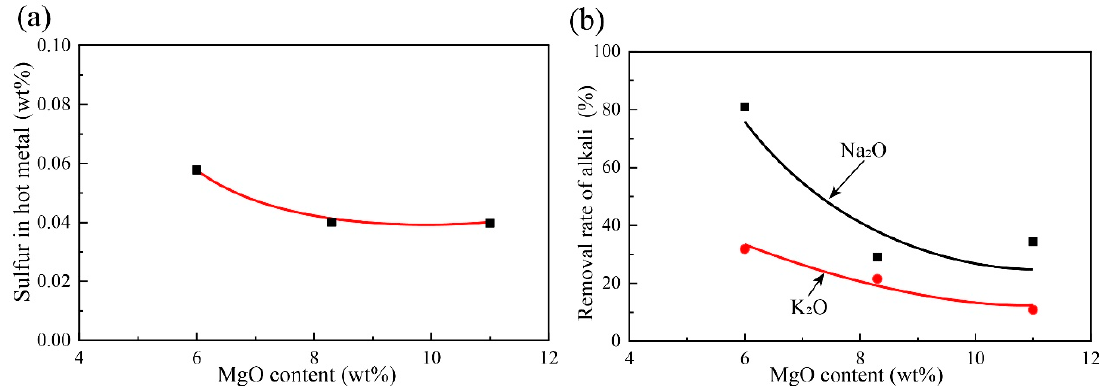
Figure 5. Effect of MgO content on the desulfurization and the removal of alkali at slag-to-metal ratio of 200 kg/t ( a ) Desulfurization; ( b ) the removal of alkali.